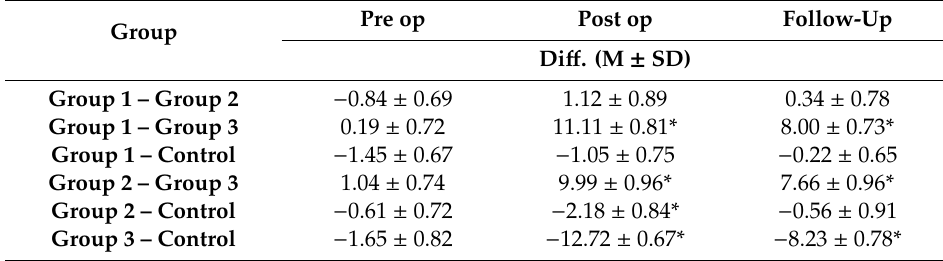
Table 4. Mean di ff erence between groups according to measurement time. (*: Bonferroni post hoc test ( p = 0.05 / 3).)